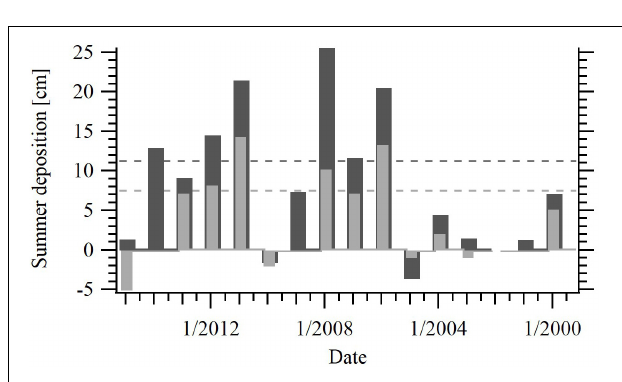
FIGURE 6 | Summer deposition of the years 2000–2015 derived from the AWS 9 snow height sensor displayed against time; dashed lines indicate the expected summer deposition, bars show the observed summer deposition; color code: light gray = 4-month summer period November–February, dark gray = 6-month summer period from September equinox to March